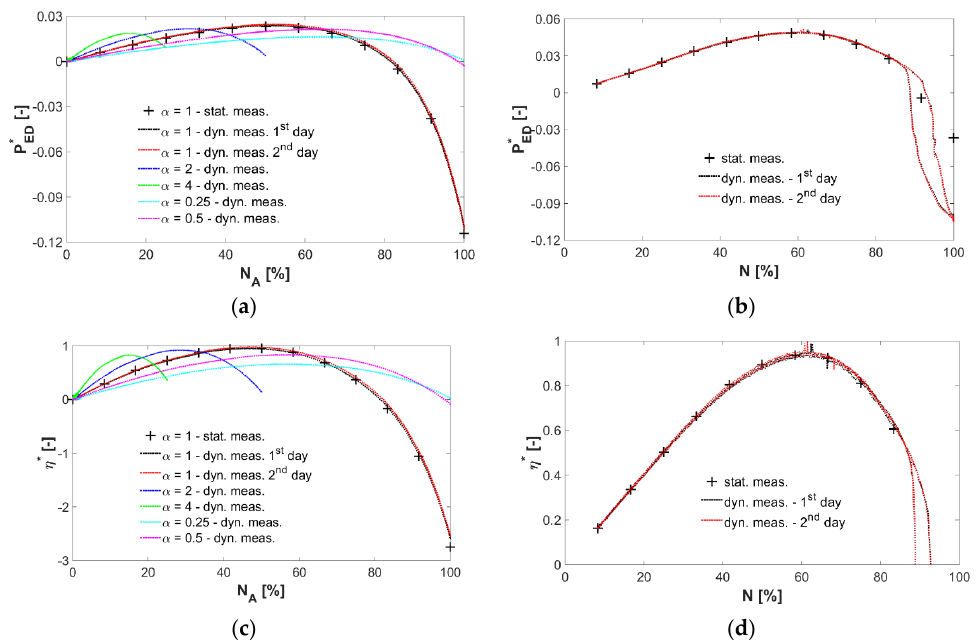
Figure 9. Dynamic versus static power coefficient and efficiency measurements during one forth and back cycle at fixed testing inflow conditions: ( a ) variation of the counter-rotating microturbine power coefficient (N p1,2,3 = 1500 min − 1 ); ( b ) variation of the PAT power coefficient (N p1,2,3 = 2000 min − 1 ); ( c ) variation of the counter-rotating microturbine efficiency (N p1,2,3 = 1500 min − 1 ); ( d ) variation of the PAT efficiency (N p1,2,3 = 2000 min − 1